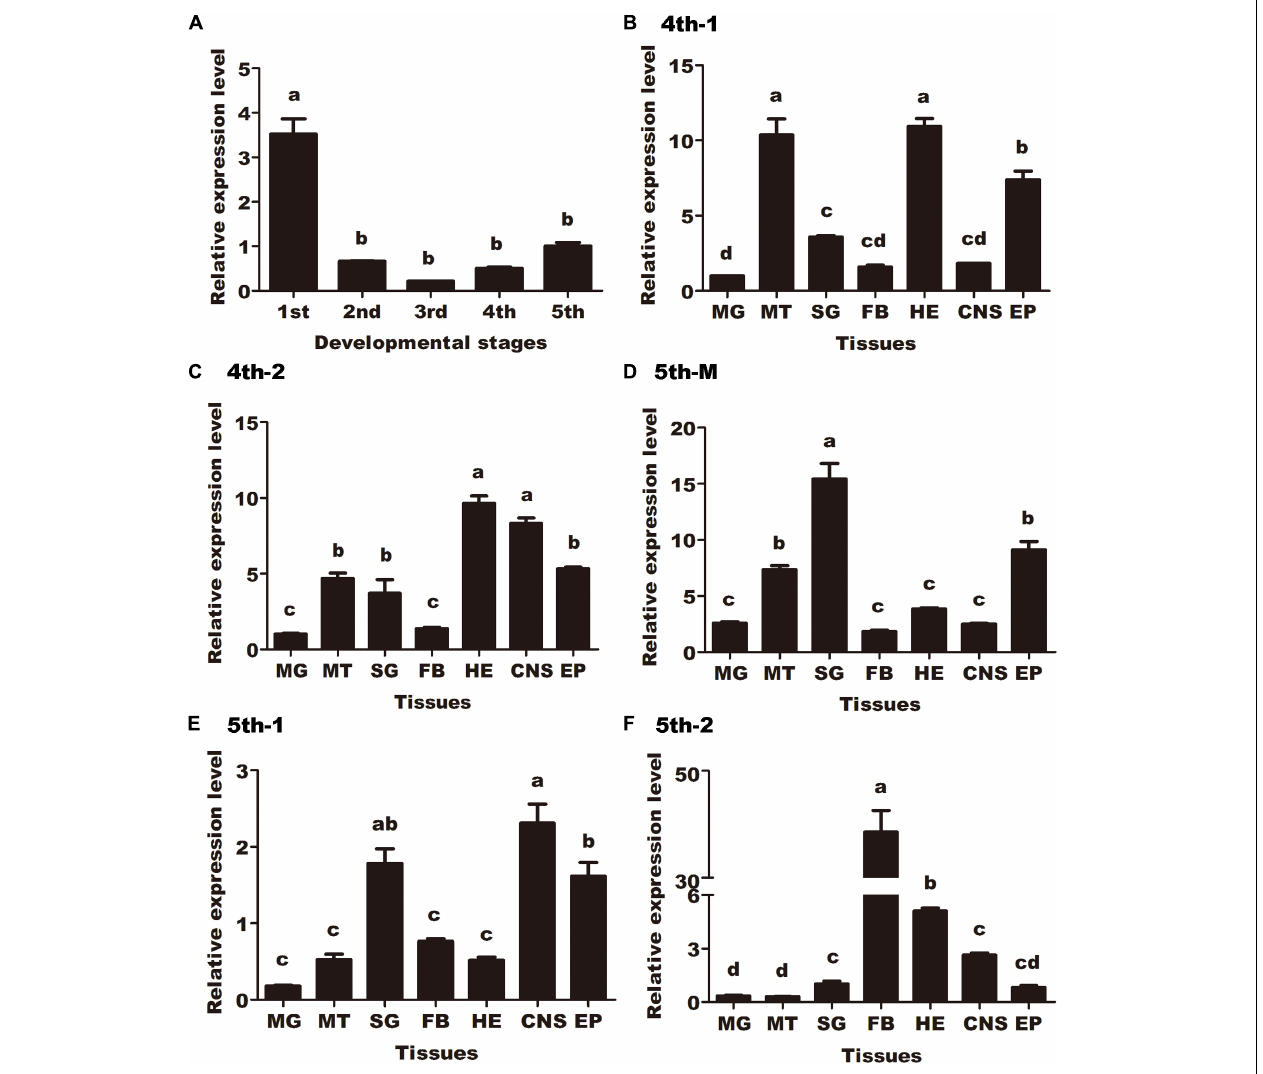
FIGURE 1 | Developmental expression pattern and spatial distributions of Helicoverpa armigera calcineurin A ( HaCNA ) in larvae as determined by quantitative real-time PCR. (A) Relative expression levels of HaCNA in first-instar larvae (1st), second-instar larvae (2nd), third-instar larvae (3rd), fourth-instar larvae (4th), and fifth-instar larvae (5th). (B) Relative expression levels of HaCNA in different tissues (MG, midgut; MT, malpighian tubes; SG, salivary glands; FB, fat body; HE, hemocyte; CNS, central nervous; EP, epidermis) in the first day of 4th larvae. (C) Relative expression levels of HaCNA in different tissues in the second day of 4th larvae. (D) Relative expression levels of HaCNA in different tissues in fifth instar molting stage. (E) Relative expression levels of HaCNA in different tissues in the first day of 5th larvae. (F) Relative expression levels of HaCNA in different tissues in the second day of 5th larvae. Statistically significant differences for experimental comparisons are indicated by different small letters [analysis of variance (ANOVA) and Tukey’s test, P < 0.05; DPS7.05]. Values shown are means and standard errors.